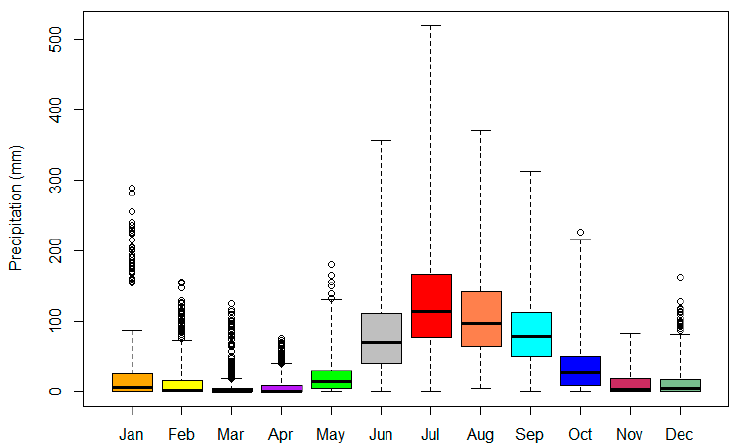
Figure 2. Boxplots for monthly precipitation in 36 weather stations of